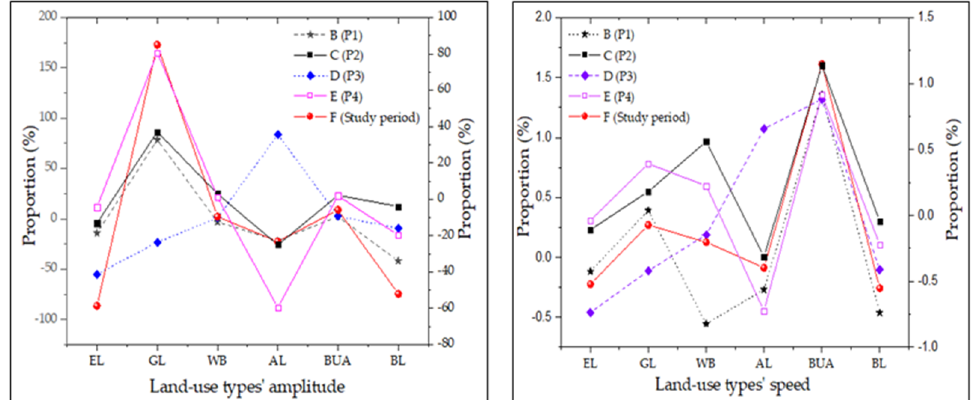
Figure 3. (P1–P4) show the speed and amplitude of land use types for 2003–2007, 2007–2011, 2011– 2015, and 2015–2019, respectively. F represents the study area in 2003–2019, in which EC: ecological land; GL : grassland; WB: water bodies; AL: agricultural land, BUA: built-up area; BL: barren